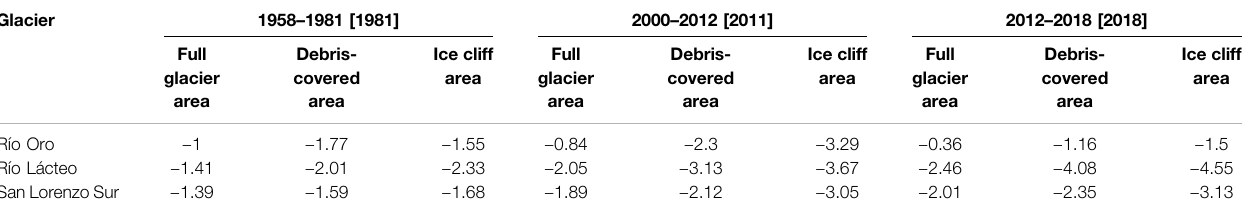
TABLE 6 | Elevation changes (m a − 1 ) for full glacier, debris-covered ice and ice cliff areas. The values in bracket for each study period indicate the year in which the ice cliff mapping was carried out. Glacier Full